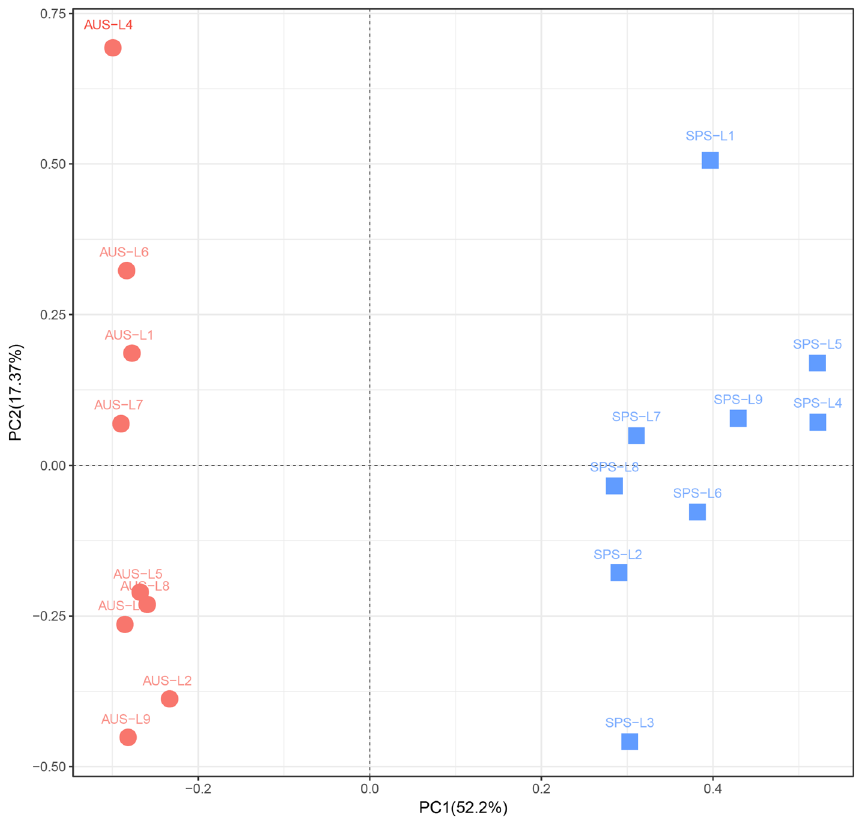
Figure 5. Principal component analysis of phoD -harboring bacterial genera detected in the sediments of Sancha Lake in the spring and autumn. SPS Spring Location, AUS Autumn Location.